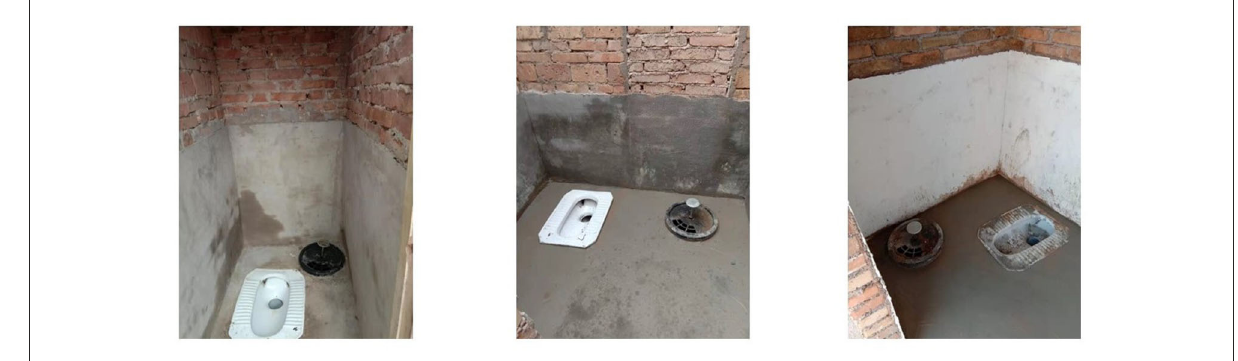
FIGURE3 Examples of sanitation; photos provided by survey respondents.